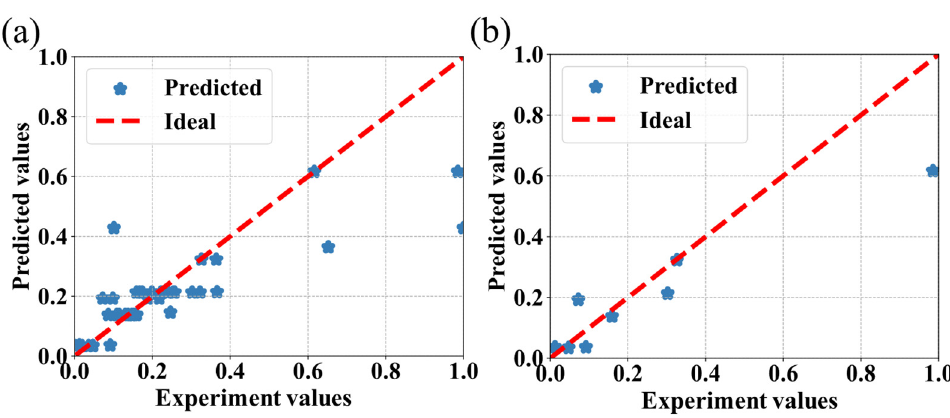
Figure 7. Performance of the AdaBoost algorithm for the prediction of the IBU loading capacity of MOFs associated with the experimental values. ( a ) The predictions are calculated on the entire dataset. ( b ) The predictions are exclusively calculated on the testing dataset.